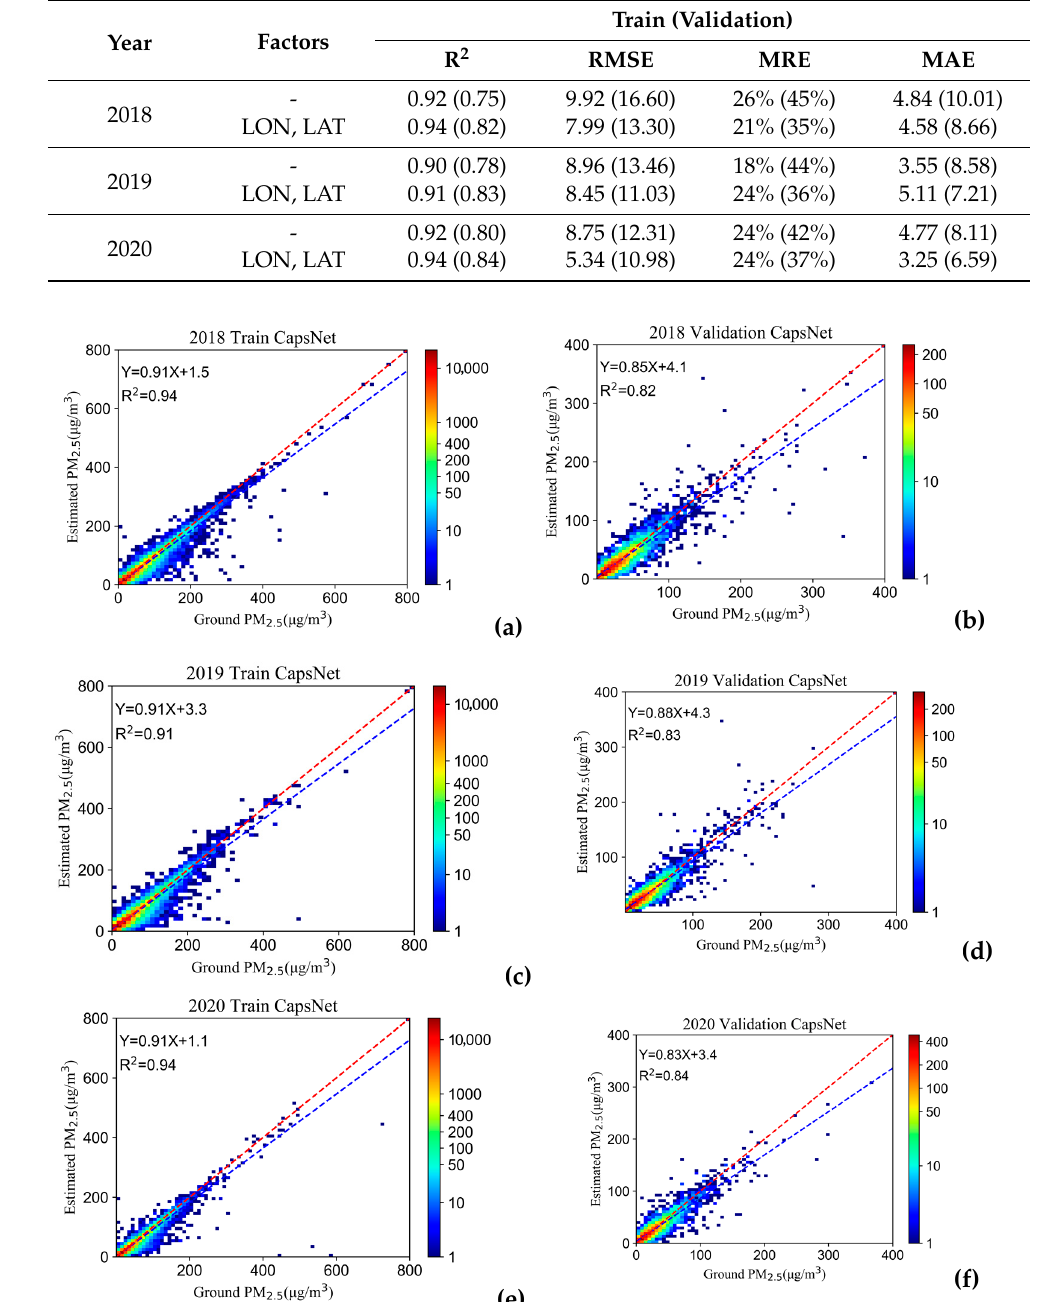
Table 2. Comparison validation of the CapsNet model fitting accuracy with and without longitude and latitude (2018–2020).